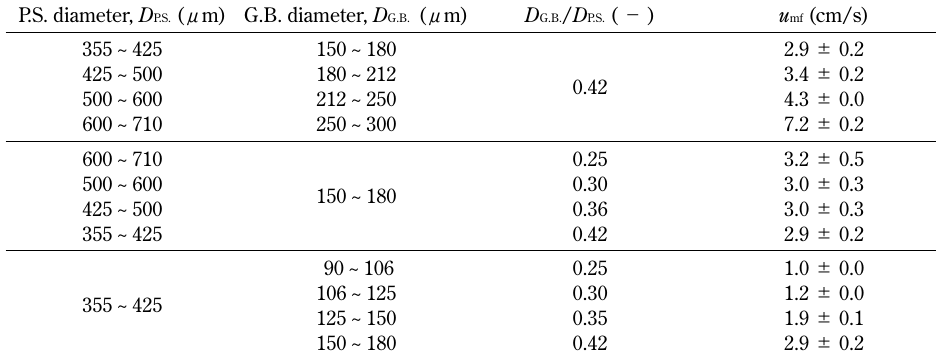
Table 3 Characteristics of fluidized particles for various D G.B. / D P.S.